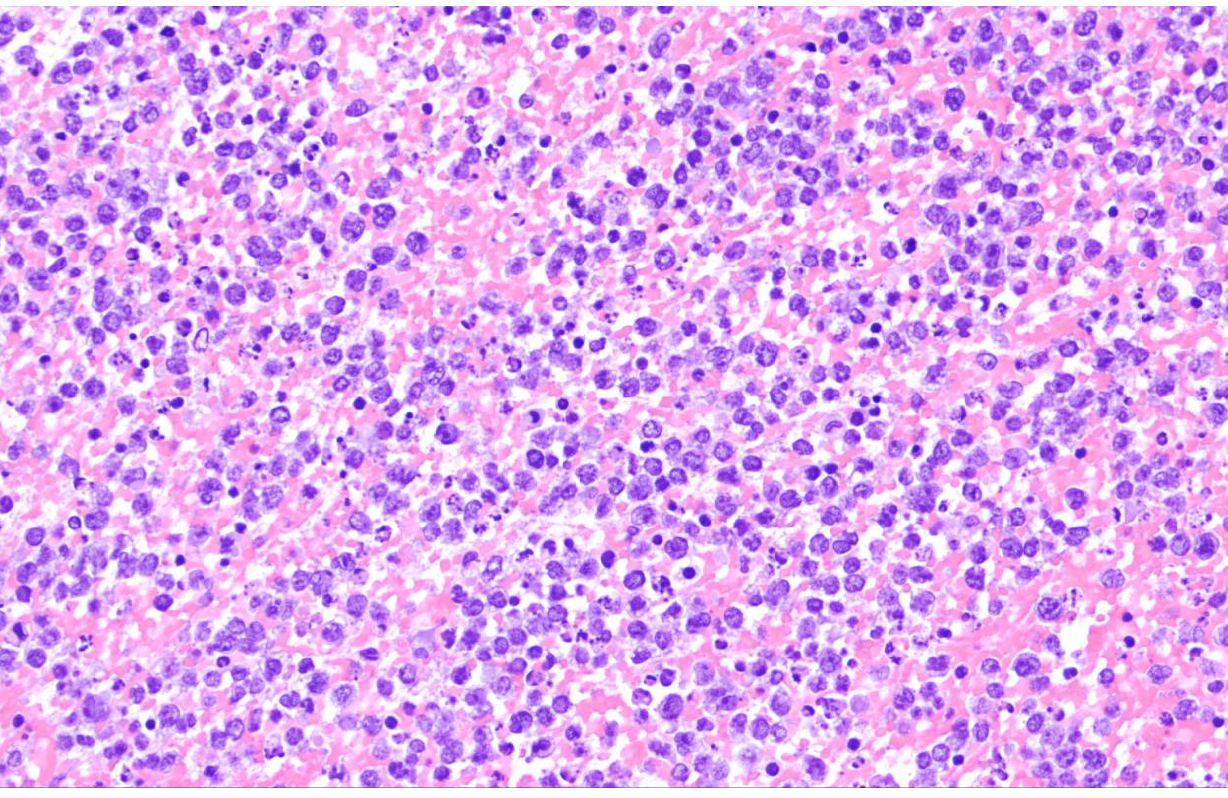
Figure 9. Fluid overload-associated large B-cell lymphoma (H&E ×200) This cytoblock preparation demonstrates massive shedding of large lymphoid cells into the pleural fluid.